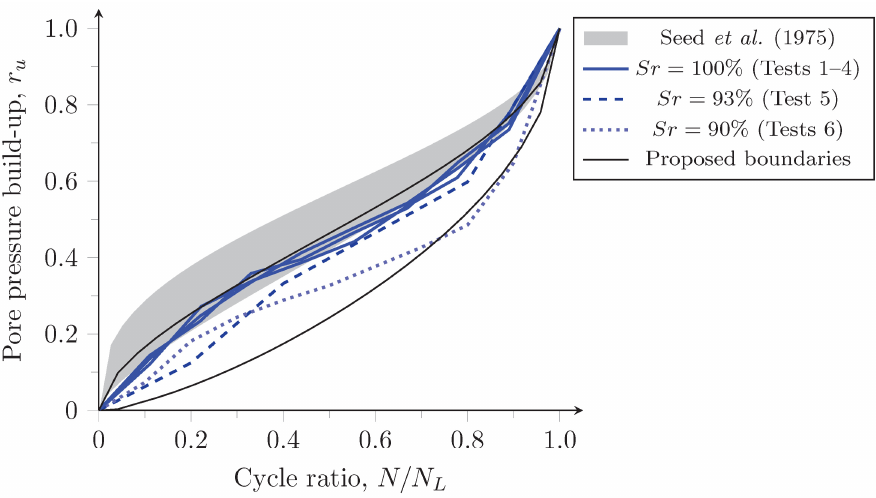
Figure 11. Evolution of pore pressure build-up for the different degrees of